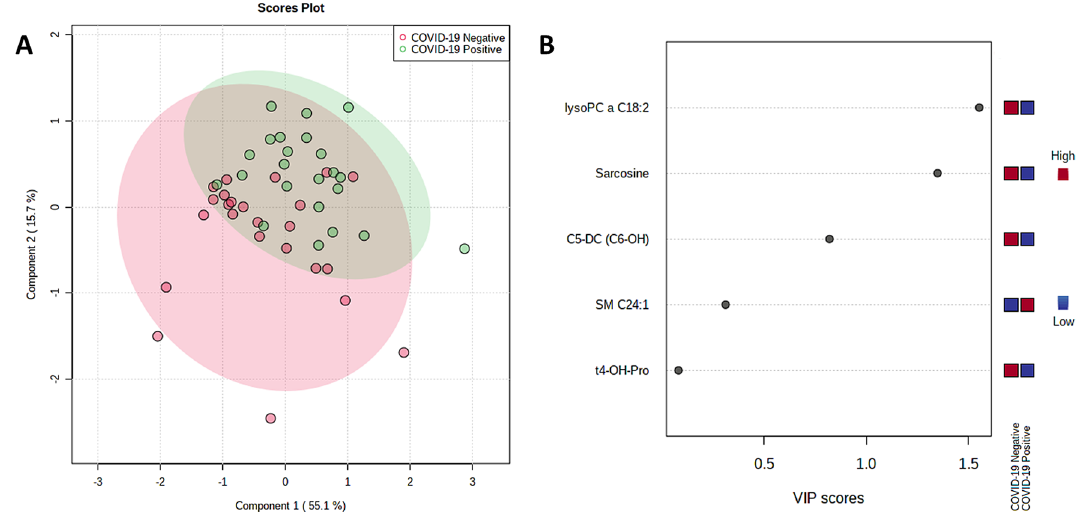
Figure 7. ( A ) PLS-DA plot and ( B ) high VIP score metabolites for saliva, COVID-19 positive versus COVID- 19